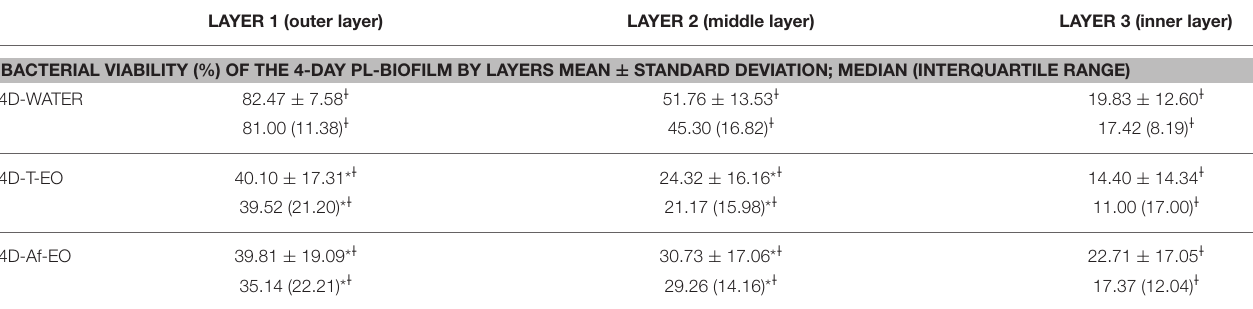
TABLE 3 | Bacterial viability of the PL-biofilm after 4 days of applying the three different rising protocols, differentiating by layers. LAYER 1 (outer layer) LAYER 2 (middle